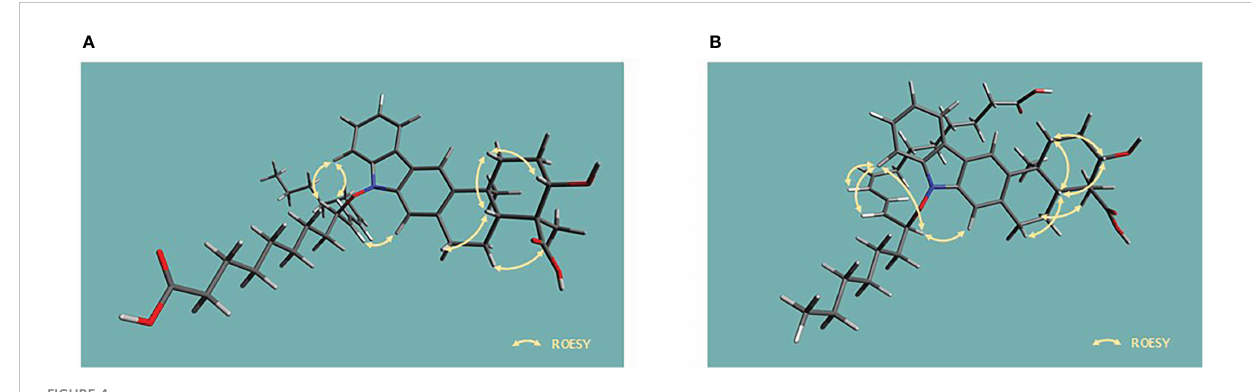
FIGURE 4 Energy-minimized structures for the key ROESY correlations present in (A) lipoxiamycin A (1) and (B) lipoxiamycin B